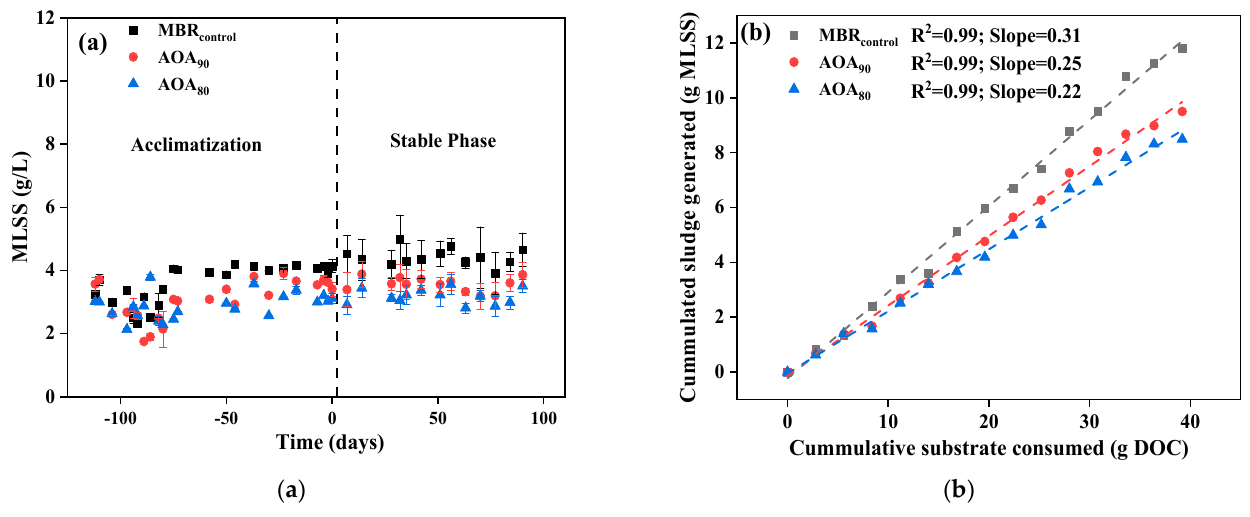
Figure 2. ( a ) The change in the averaged MLSS concentration between acclimatization and stable operation phases in MBR control , AOA 90 and AOA 80 , ( b ) The observed sludge yield (Y obs ) in MBR control , AOA 90 and AOA 80 .